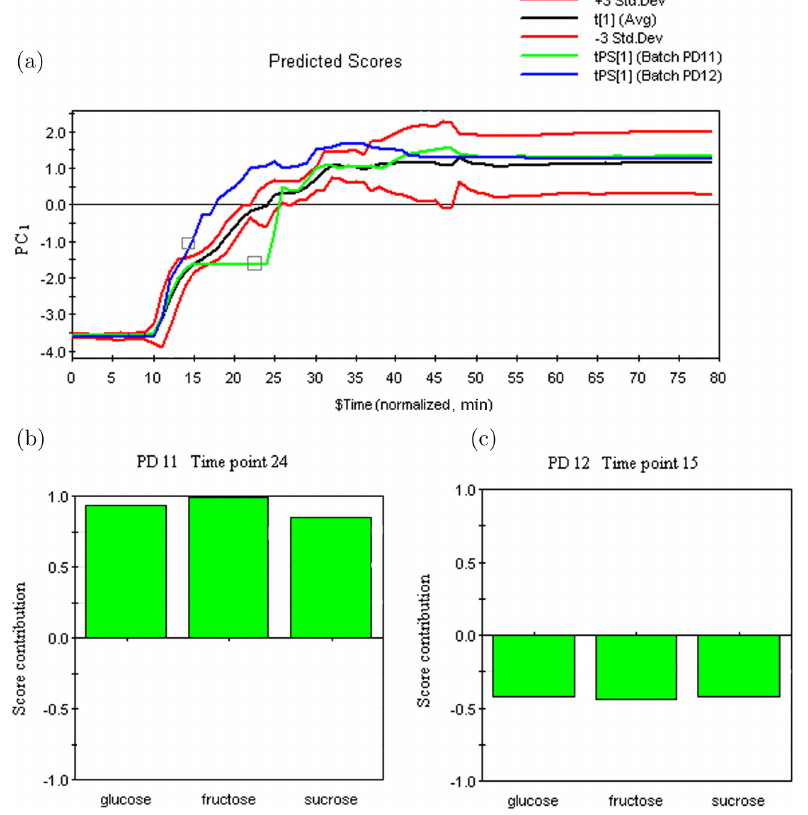
Fig. 5. Process monitoring of the PD baths: (a) A control plot of the PD baths based on the six PC batches, (b) score contribution of bath PD11 at the timepoint 24, and (c) score contribution of bath PD12 at the timepoint 15.